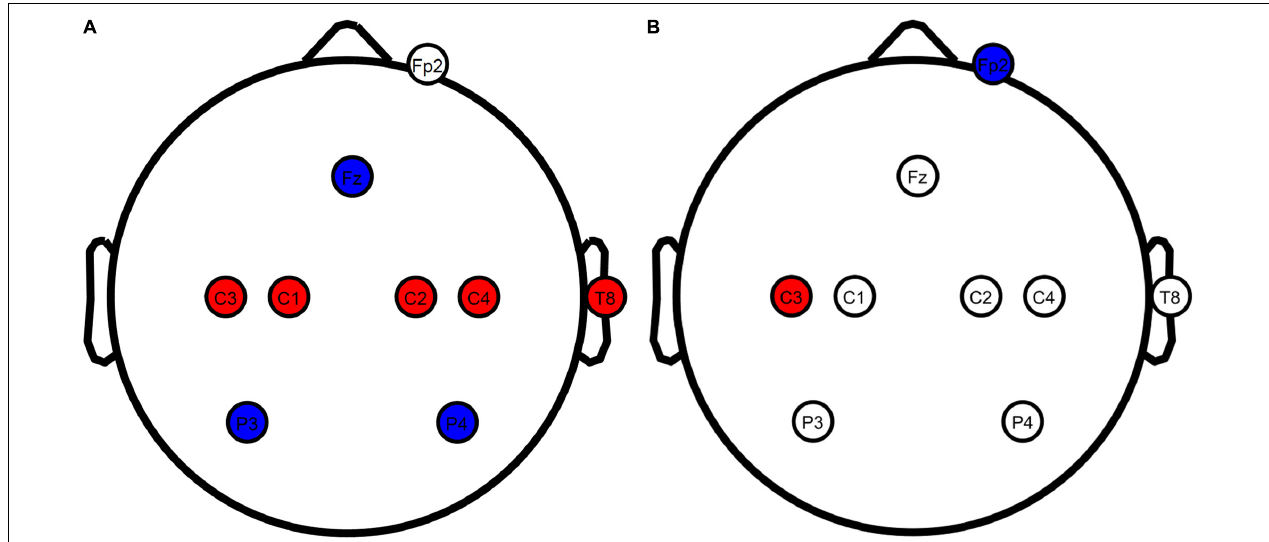
FIGURE 1 | TDCS electrode configurations overview. (A) Motor network and sham tDCS configurations. (B) Conventional tDCS configuration. Red, anodes; blue, cathodes; white, electrodes not actively used for the stimulation configuration. Stimulation electrodes were inserted at all locations in all conditions to blind the participants from the applied configuration. Figure created using